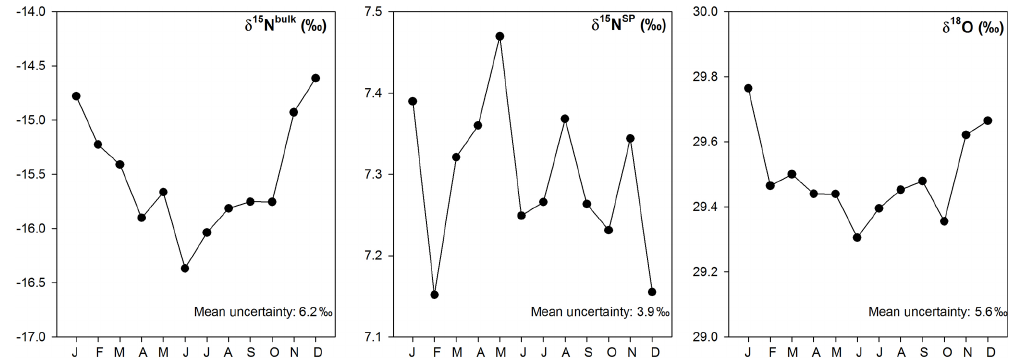
Figure 9. Simulated seasonal variations of isotopic signatures for overall N 2 O sources based on the bottom-up approach; uncertainties shown in figures are comparable to the ranges of isotopic signatures for variable sources as found in literature. Table 5. Isotopic signatures for the overall, anthropogenic and major N 2 O sources contributing to N 2 O variations at Jungfraujoch. Source signatures were estimated based on a bottom-up approach, with literature-derived isotopic signatures and fluxes for variable sources under the Swiss Meteotest emission